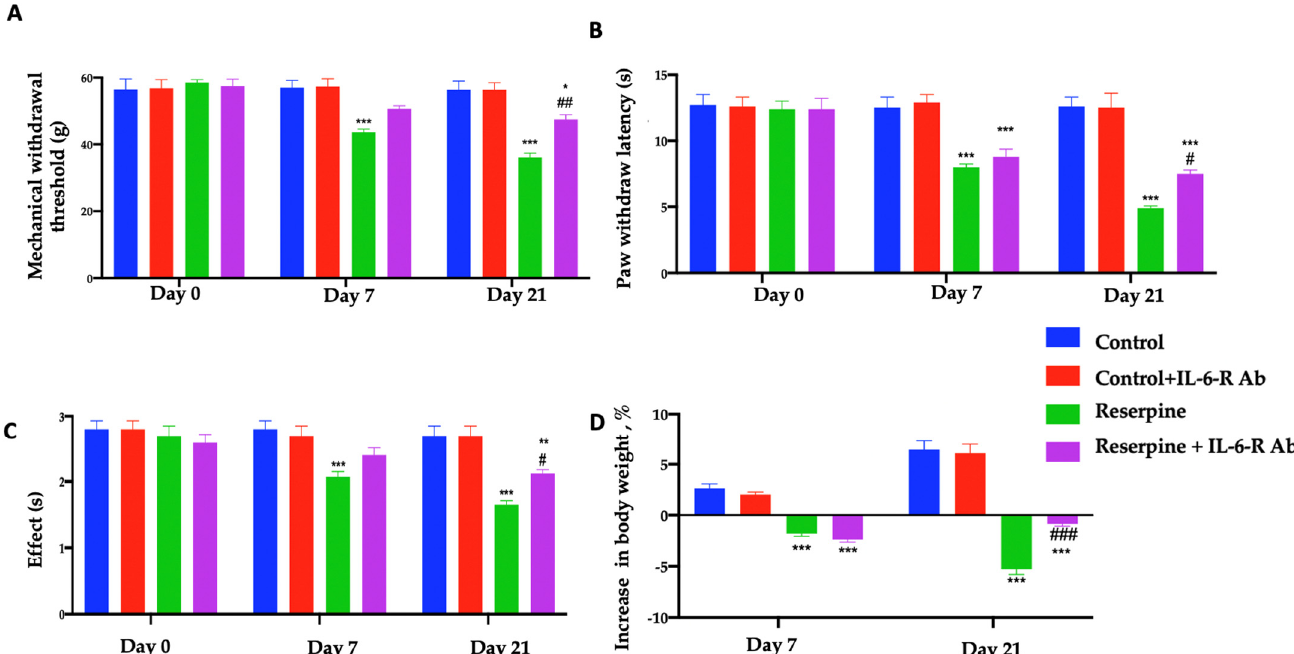
Figure 2. Effects of IL-6-R Ab on behavioral alterations: ( A ) von Frey hair test, ( B ) hot-plate test, ( C ) tail-flick warm-water test, ( D ) weight change.